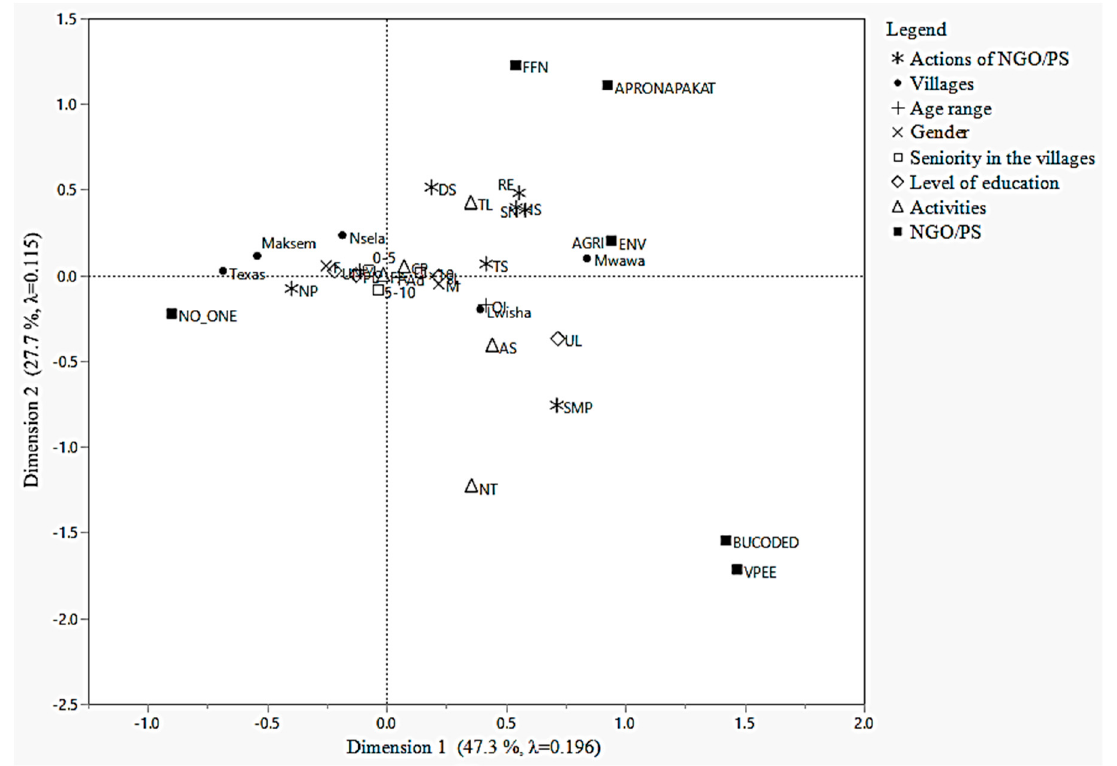
Figure 3. Sociodemographic profile of the actors participating in the different activities organized by the NGOs/provincial public services ( PS ), in a plan made up of the first two dimensions summarizing 75% of the information following a multiple correspondences factorial analysis. F : Female; M :